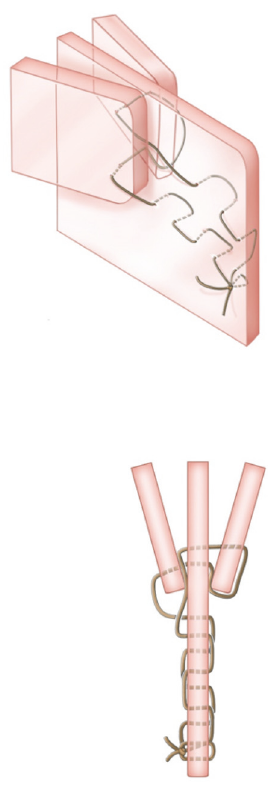
Figure 5: Oblique and axial views. Step 5. The suture is then passed anteriorly with 1cm passes. Figure 6: Oblique and axial views. Step 6. The suture is hand-tied to the original knot and divided.